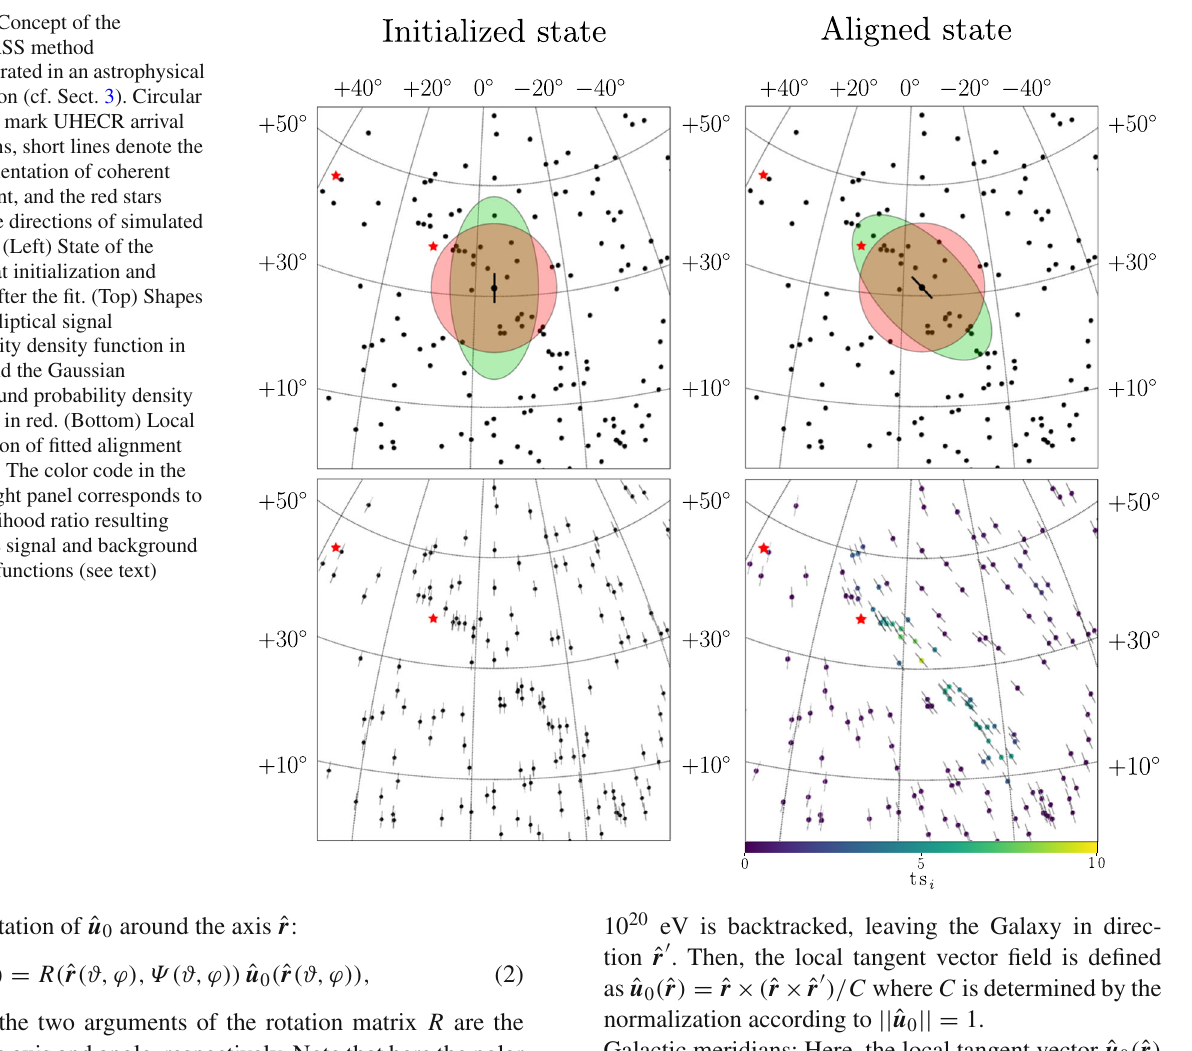
Fig. 1 Concept of the COMPASS method demonstrated in an astrophysical simulation (cf. Sect. 3). Circular symbols mark UHECR arrival directions, short lines denote the fitted orientation of coherent alignment, and the red stars show the directions of simulated sources. (Left) State of the system at initialization and (right) after the fit. (Top) Shapes of the elliptical signal probability density function in green and the Gaussian background probability density function in red. (Bottom) Local orientation of fitted alignment patterns. The color code in the lower right panel corresponds to the likelihood ratio resulting from the signal and background density functions (see text)